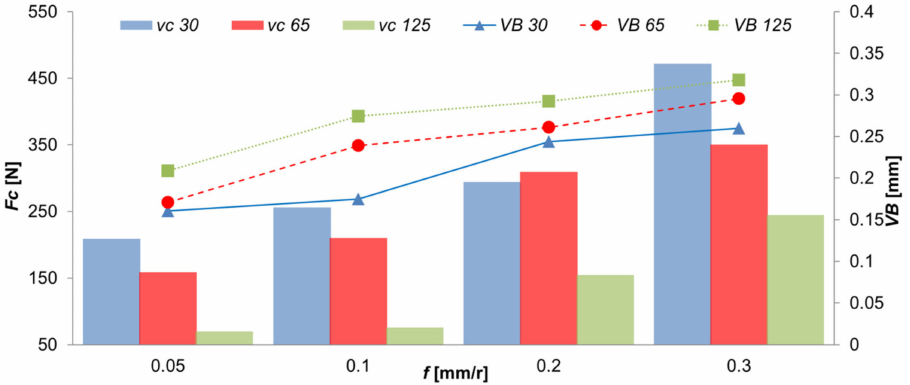
Figure 7. F c vs. VB, as a function of f and v c .